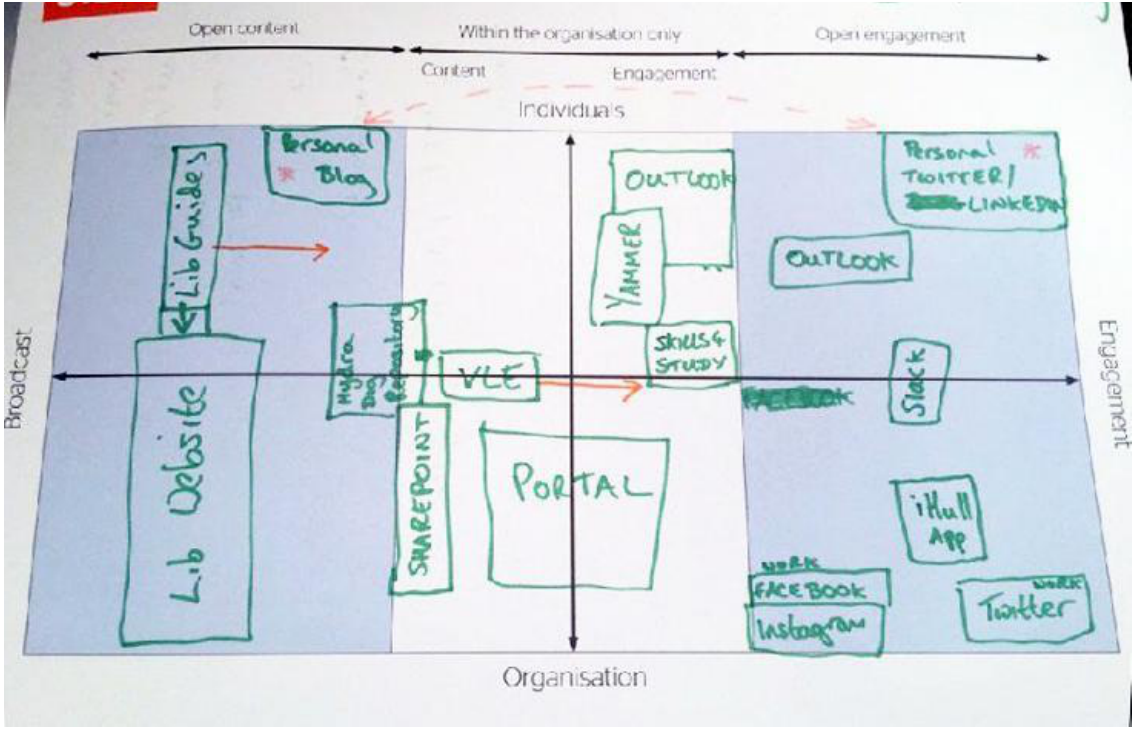
Figure 4: Organisational Map